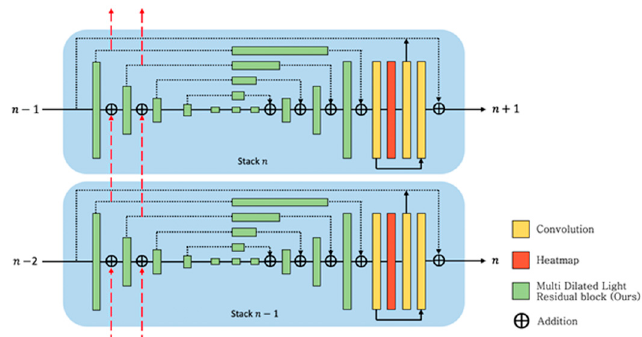
Figure 2. Proposed hourglass architecture, which utilizes an additional skip connection (red dashed arrow in the figure) from the previous stack ( n − 1) to the current stack ( n ).